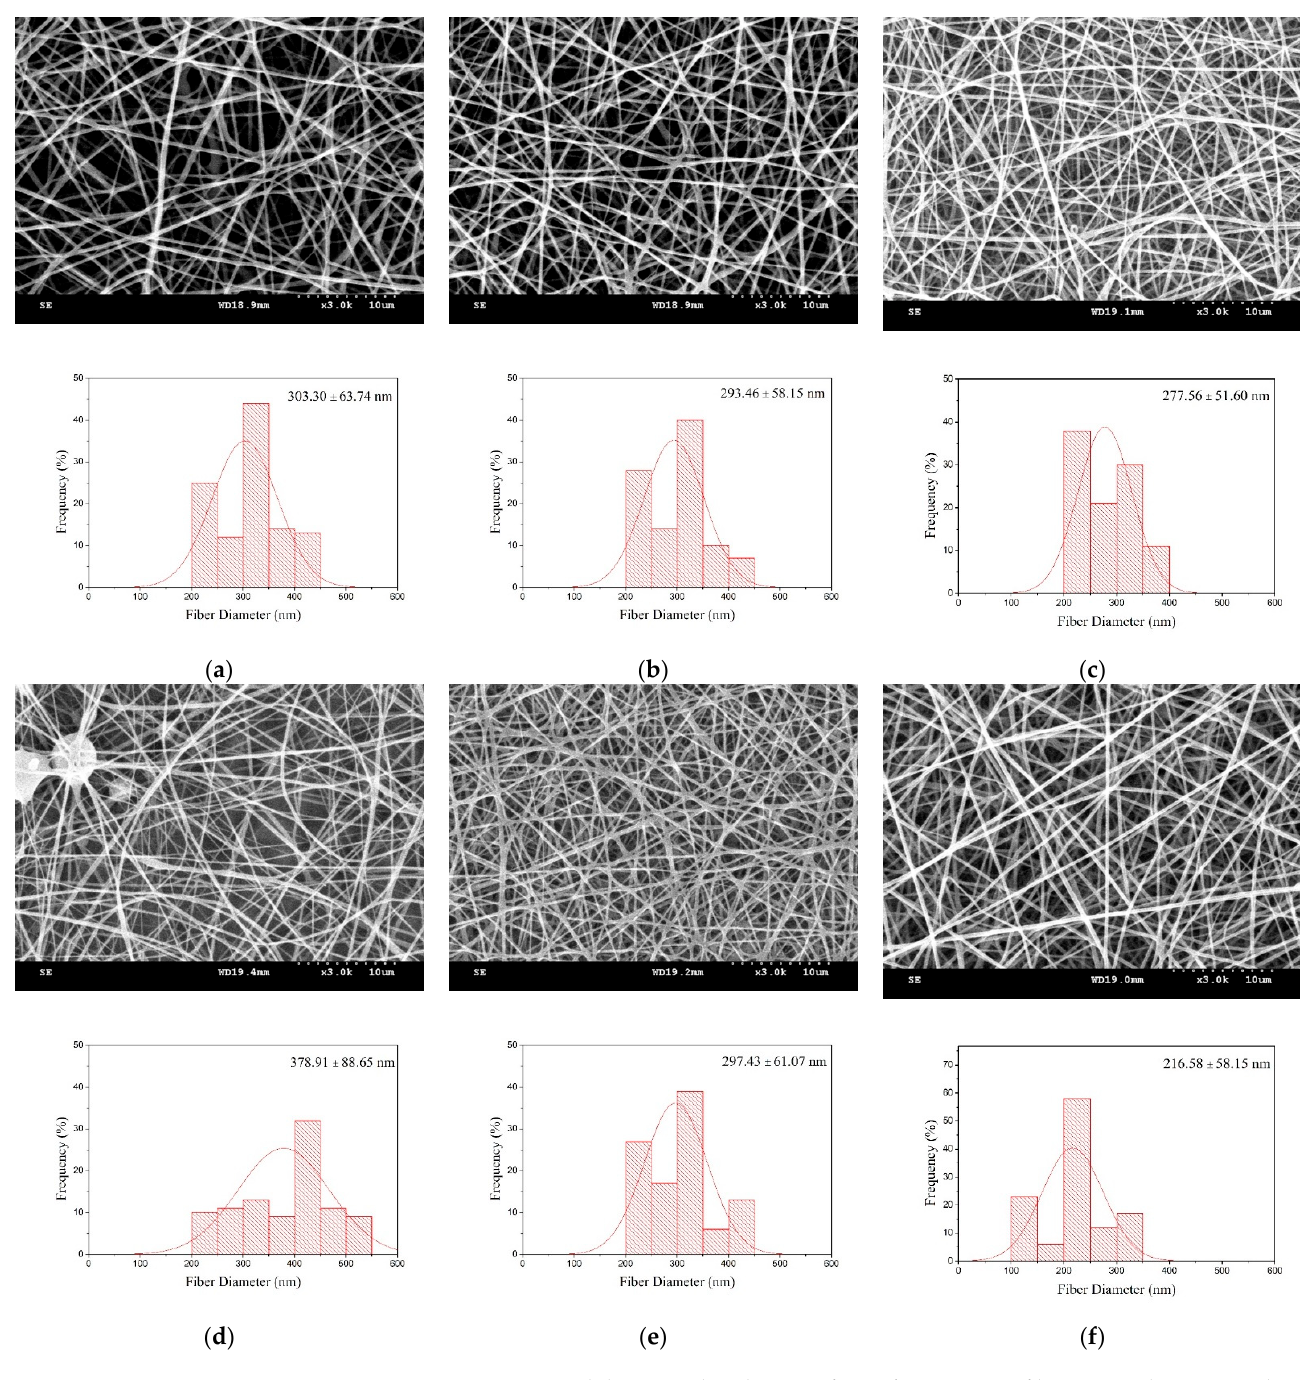
Figure 3. SEM images and diameter distribution of PVA/WS-CS nanofibrous membranes as related to blending ratio and WS-CS concentrations of ( a ) 80/20-05, ( b ) 80/20-10, ( c ) 80/20-15, ( d ) 60/40-05, ( e ) 60/40-10, and ( f ) 60/40-15.